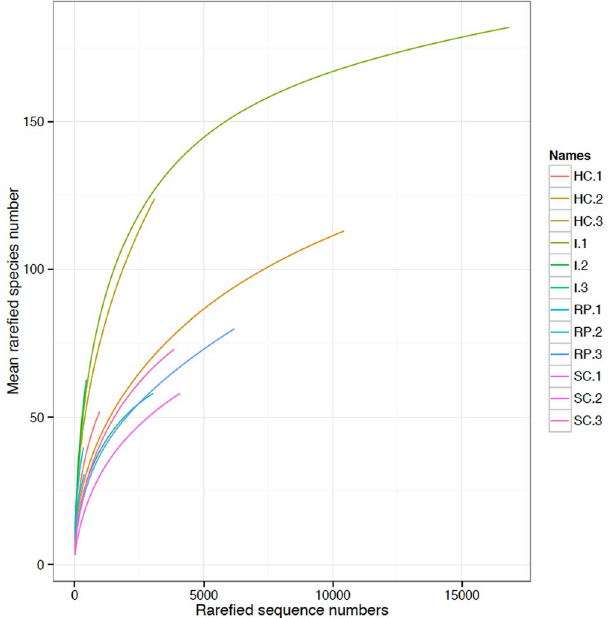
Figure 2. Operational taxonomic unit saturation profiles at 99% sequence similarity level, for the. Antarctic samples collected. Hangar Cove (HC), Islands (I), Rothera Point (RP) and South Cove (SC), where 1–3 represent each sample replicate.